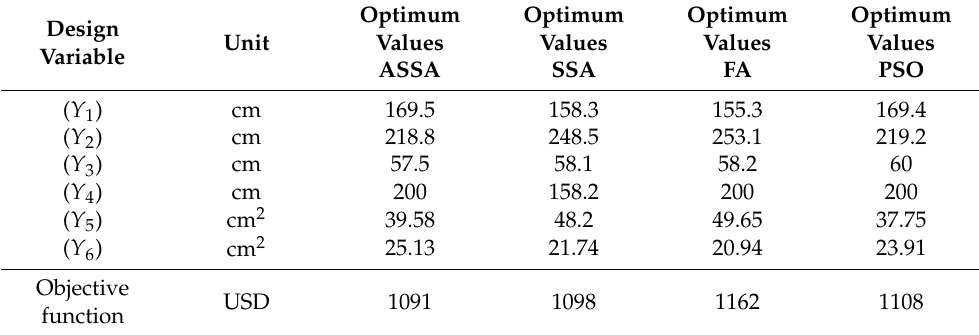
Table 15. Optimization results for design example 1.